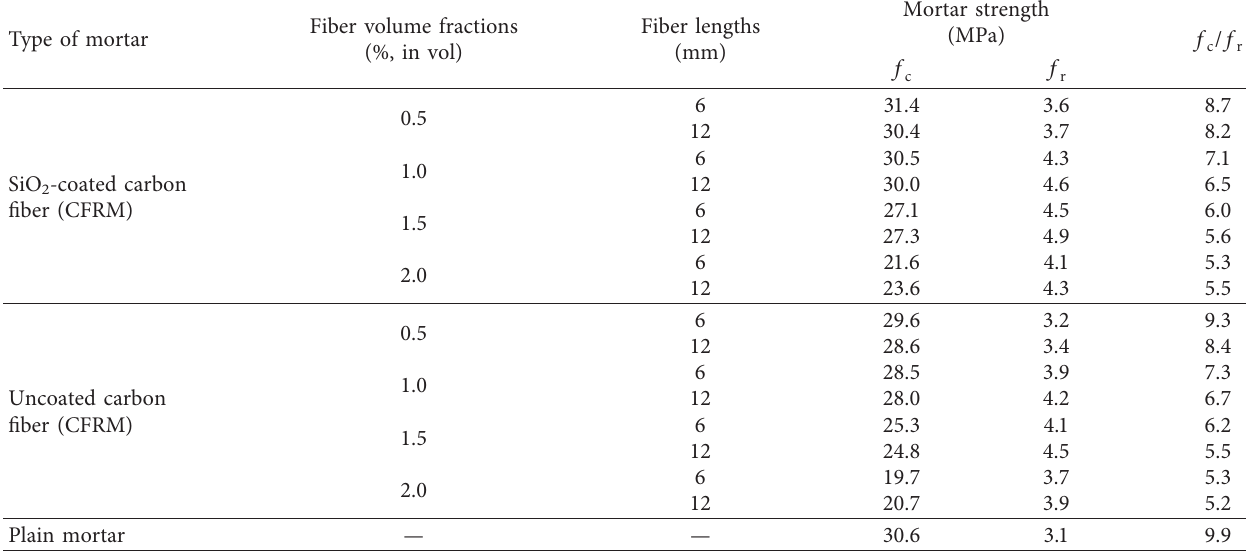
Table 5: Results of strength tests with different fiber lengths and fiber volume fractions.